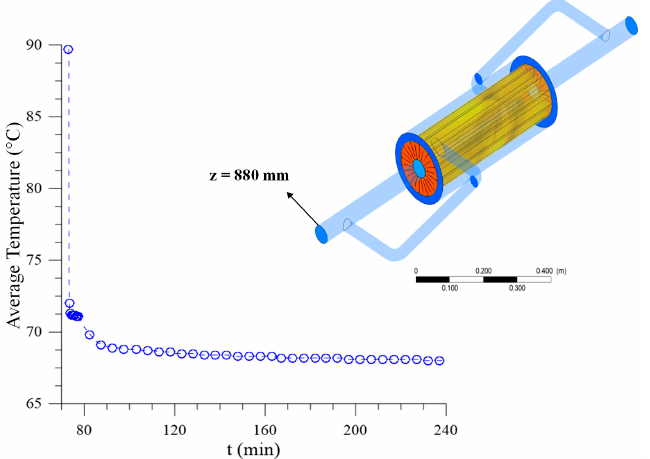
Figure 26. Average temperature during the PCM solidification process.